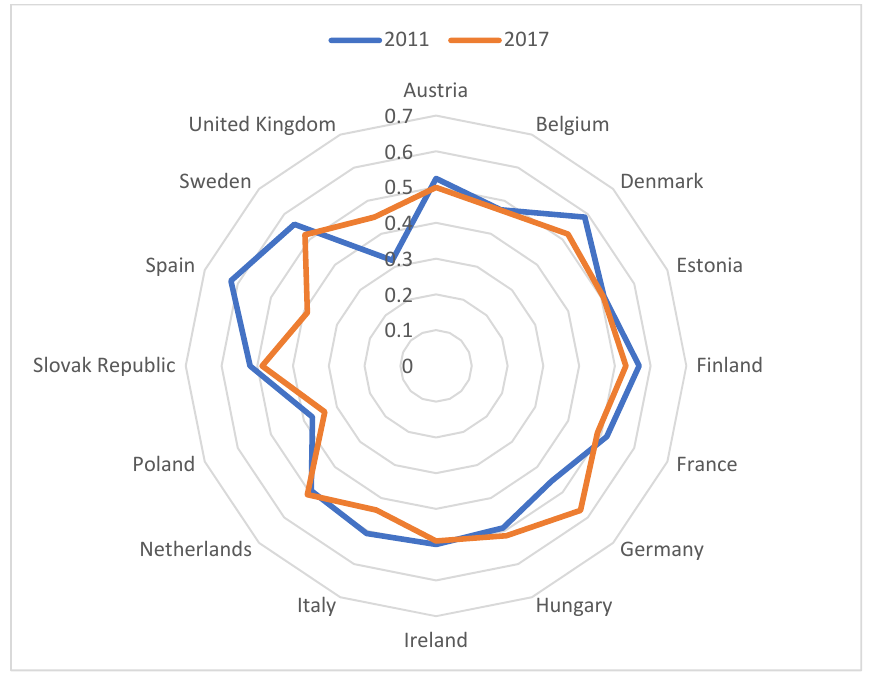
Figure 5. The average level of environmental performance of renewable energy sources R&D (million USD and PPP) for selected EU countries in 2011 and 2017.